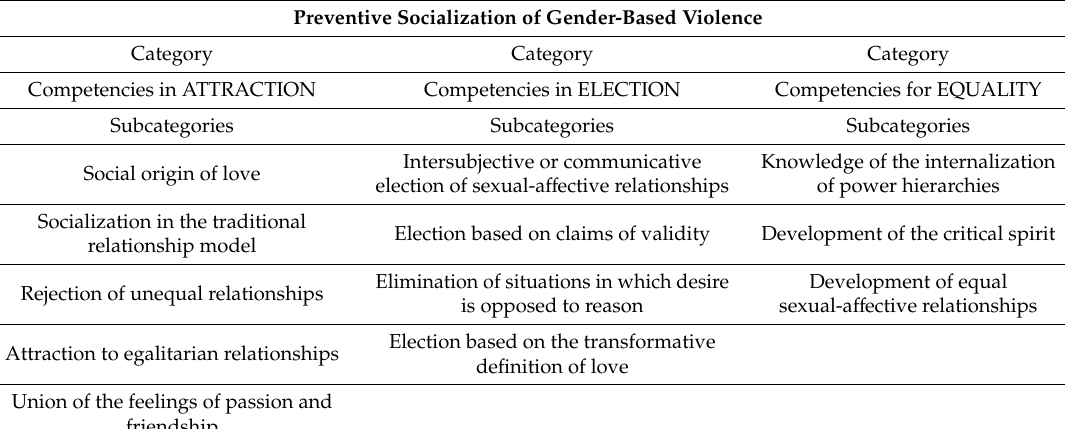
Table 2. Categories and subcategories in data analysis (G ó mez